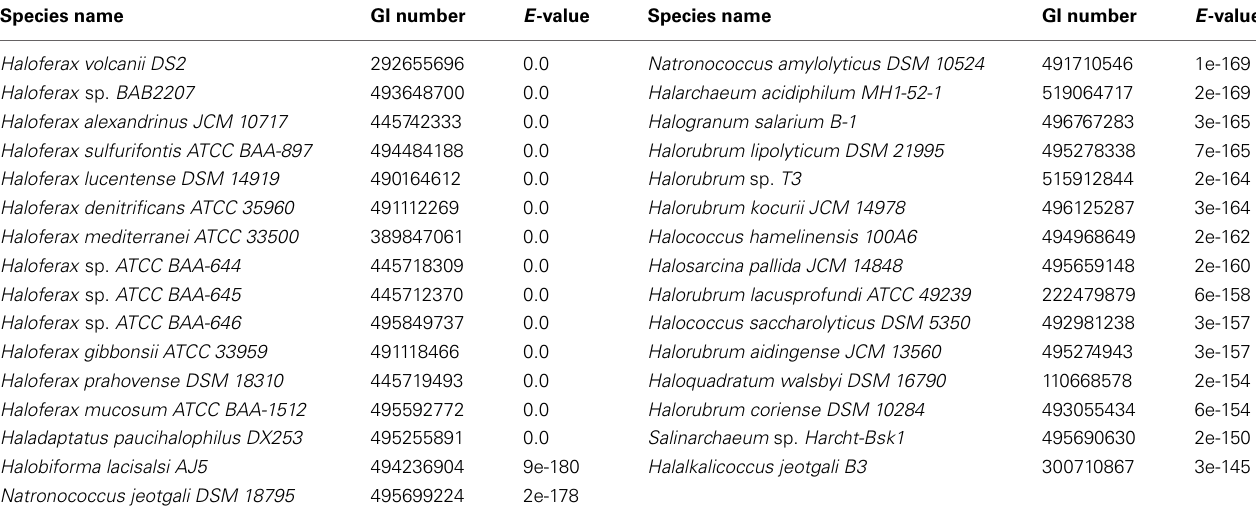
Table 4 | Results of BLASTp search using dhaK (Performed on July 29,